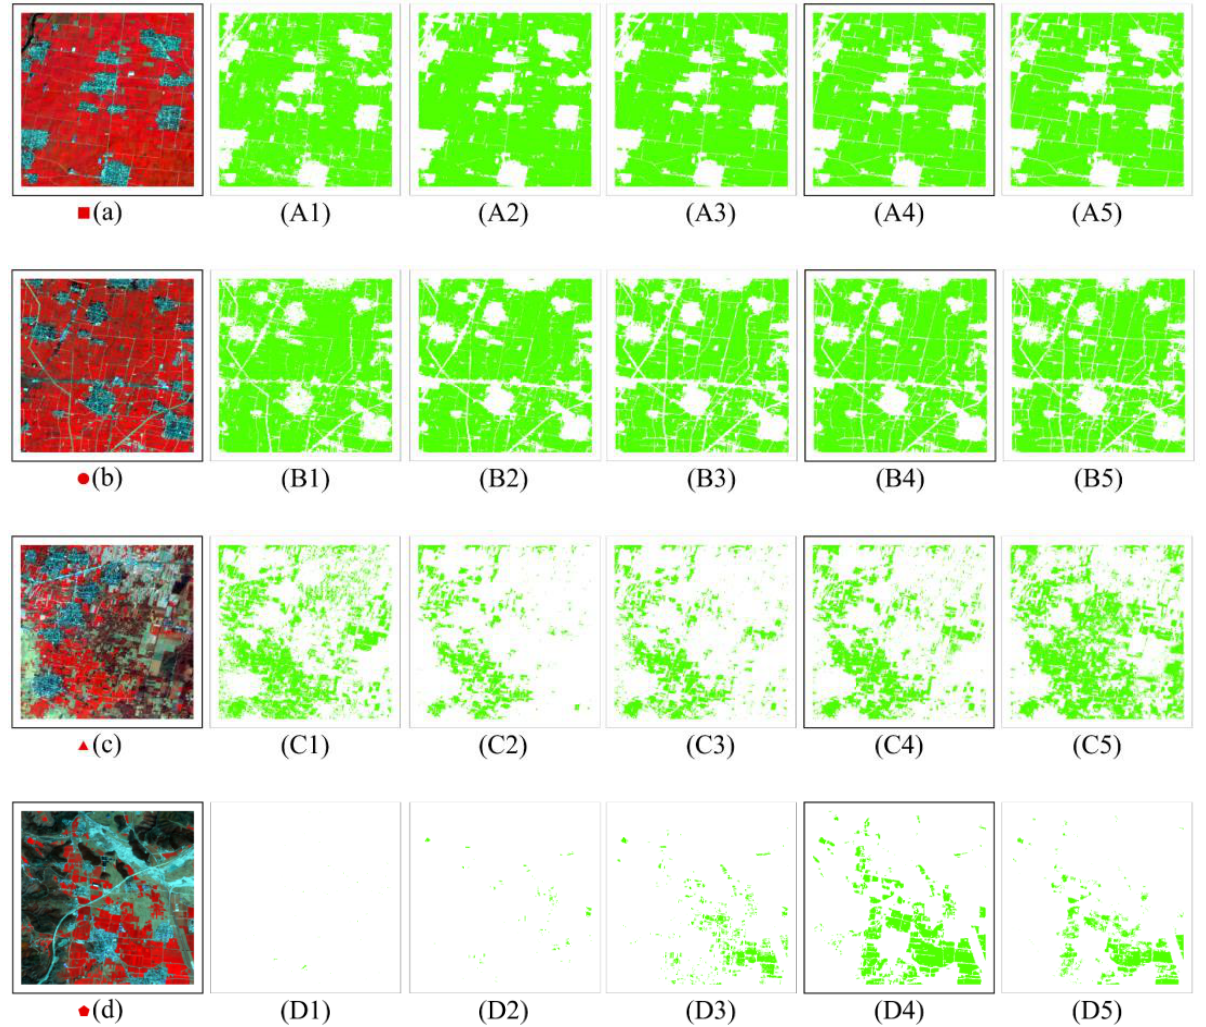
Figure 4. Results for the identification of winter wheat in four representative areas of the study area using random forest classification: ( a , b ) represent, respectively, winter wheat areas with dense planting, flat terrain; ( c , d ) represent, respectively, winter wheat areas with fragmented land use and complex terrain (Sentinel-2 false color composite images, bands 8/2/3). Parts (1) to (5) in each row show the pixels identified as winter wheat using the random forest classification during the seeding-tillering, overwintering, reviving and jointing-heading period, respectively.